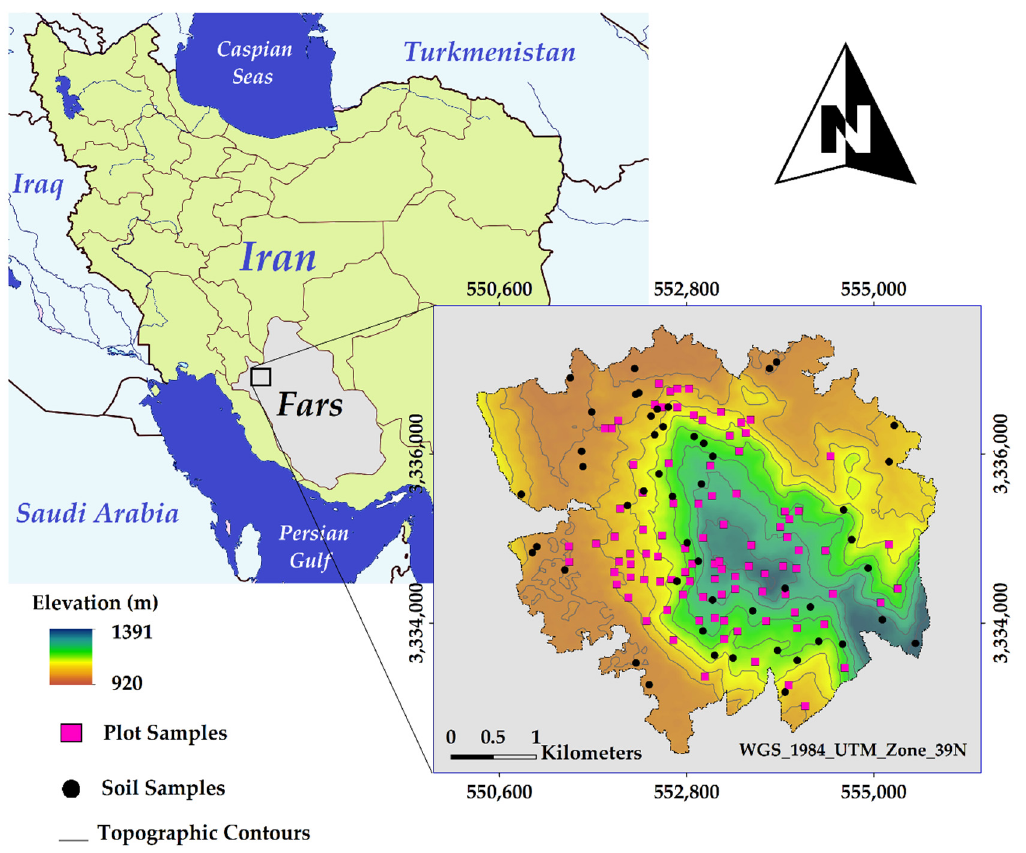
Figure 1. Geographic location of the study area used to collect species occurrence. Upper left panel— map of Iran showing the Fars province and the study area; lower right panel—study area showing the soil and vegetation plot samples.